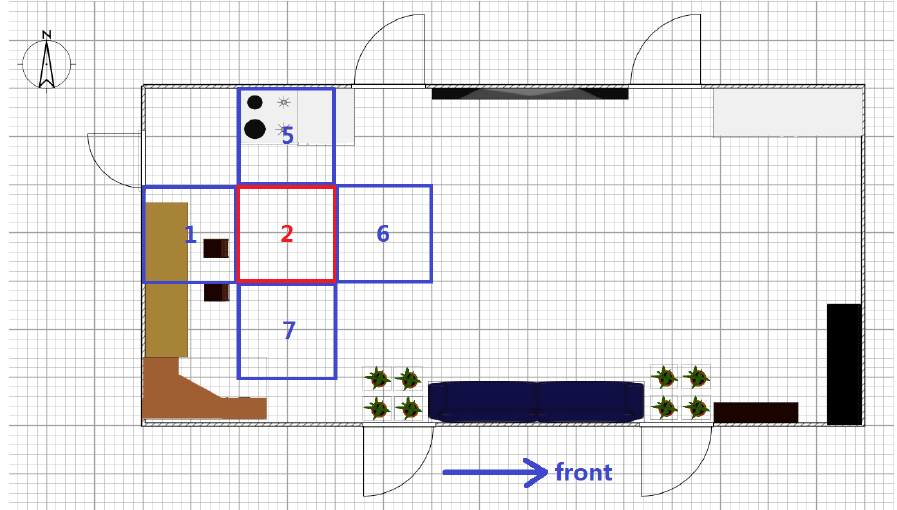
Figure 2. Illustration of indoor region partitioning.